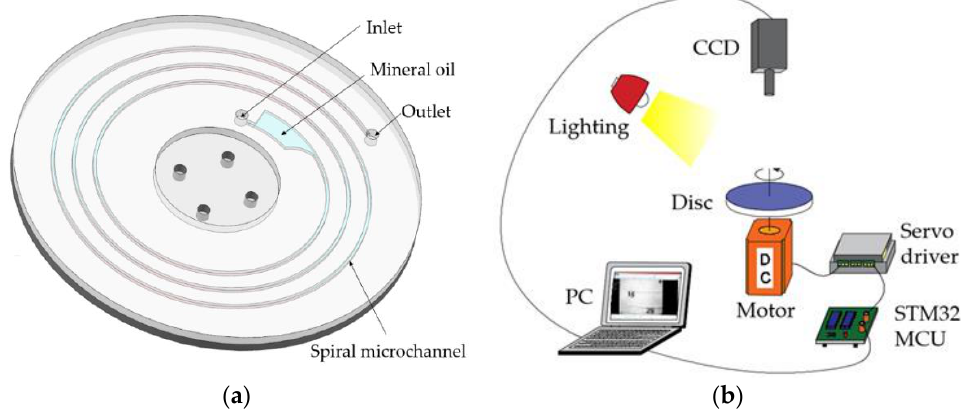
Figure 1. ( a ) The structure of the chip; ( b ) the components and instrumental configuration used for the experiments.